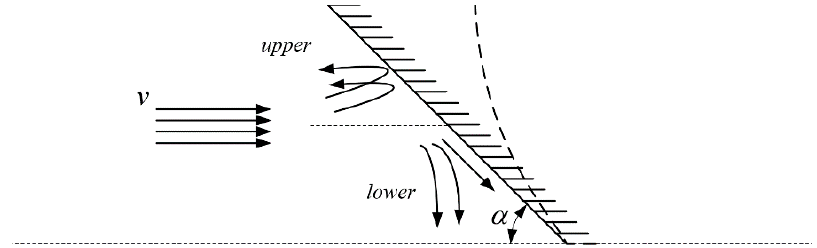
Figure 4. Diagram of water particle impact plate.